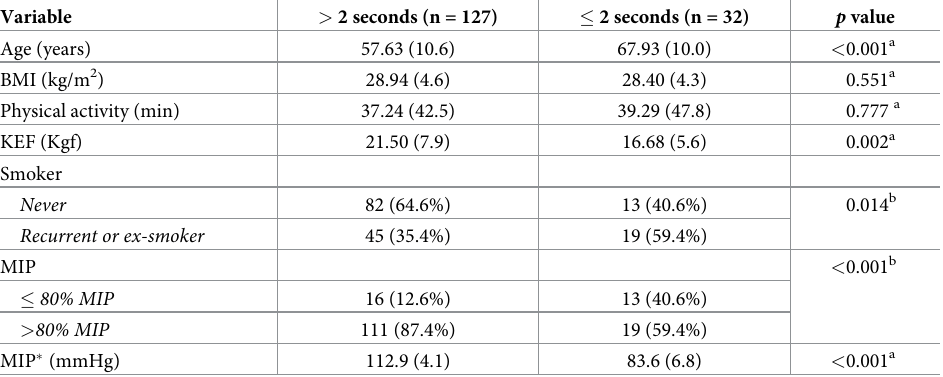
Table 2. Characteristics of the participants by postural balance scores.